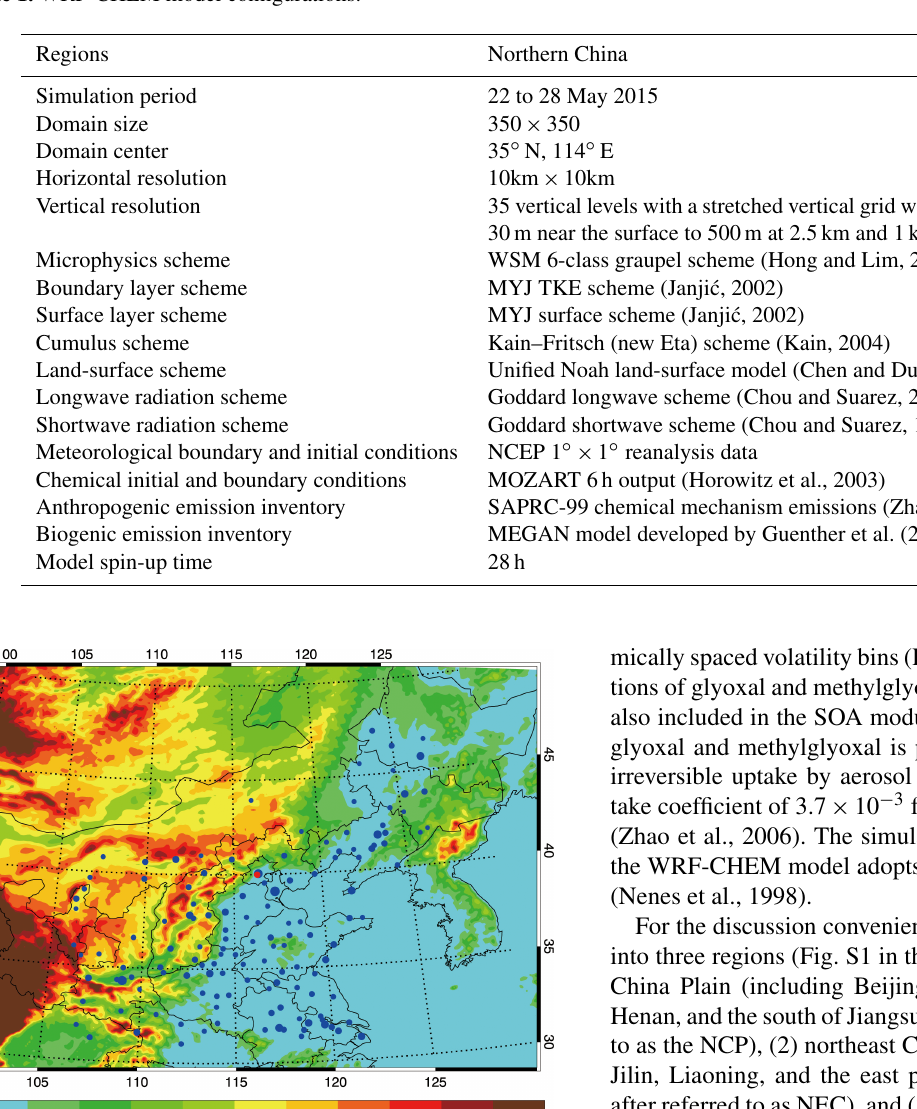
Table 1. WRF-CHEM model configurations.